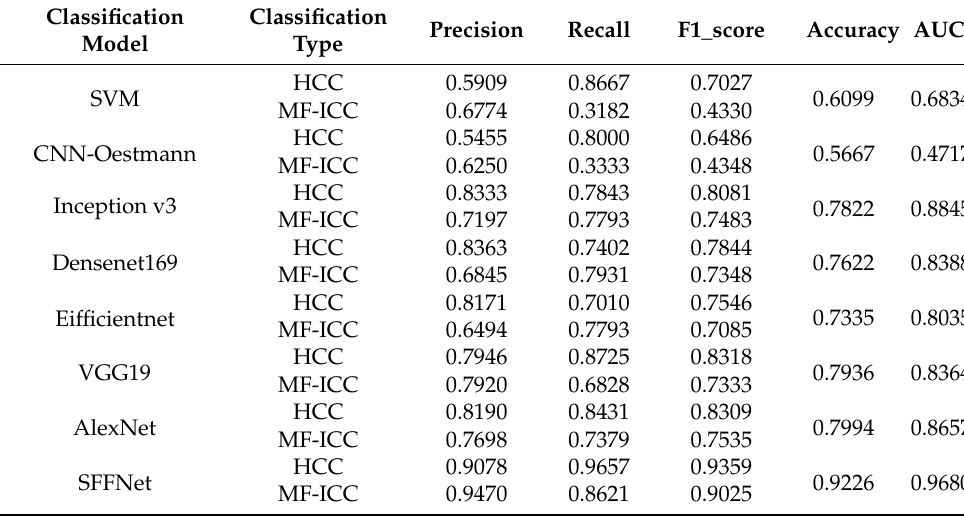
Table 3. Comparison of different classification models.